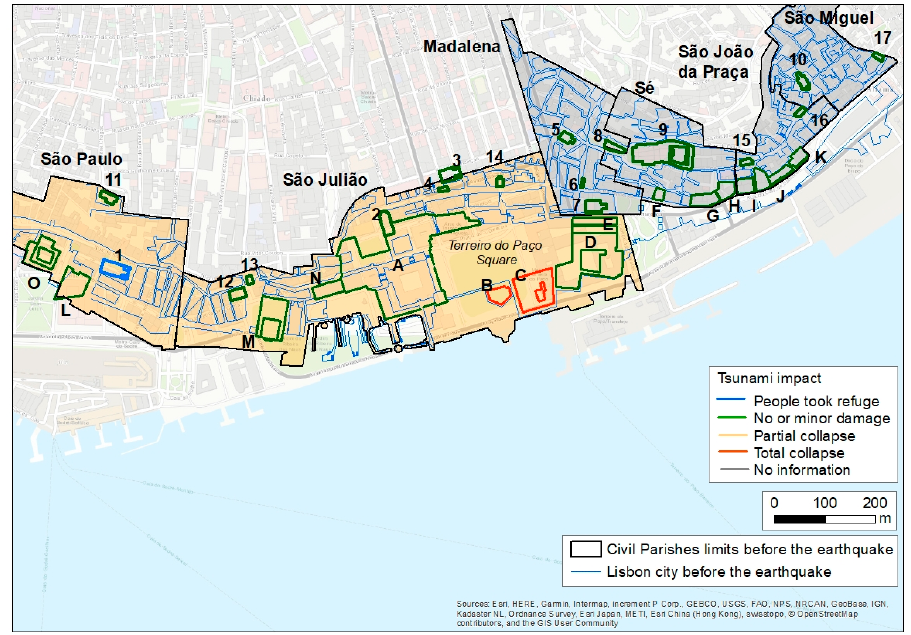
Figure 12. Damage classification caused by the tsunami on churches, other buildings and the overall damage on each civil parish at the study area. The list of churches and buildings is given in the caption of Figure 10.